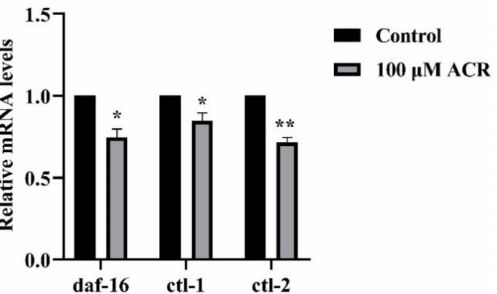
Figure 9. Effect of ACR exposure (100 µ M for 48 h) on the relative mRNA levels of C. elegans . Values are means ± SD. * Compared with the control group, p < 0.05; ** compared with the control group p <